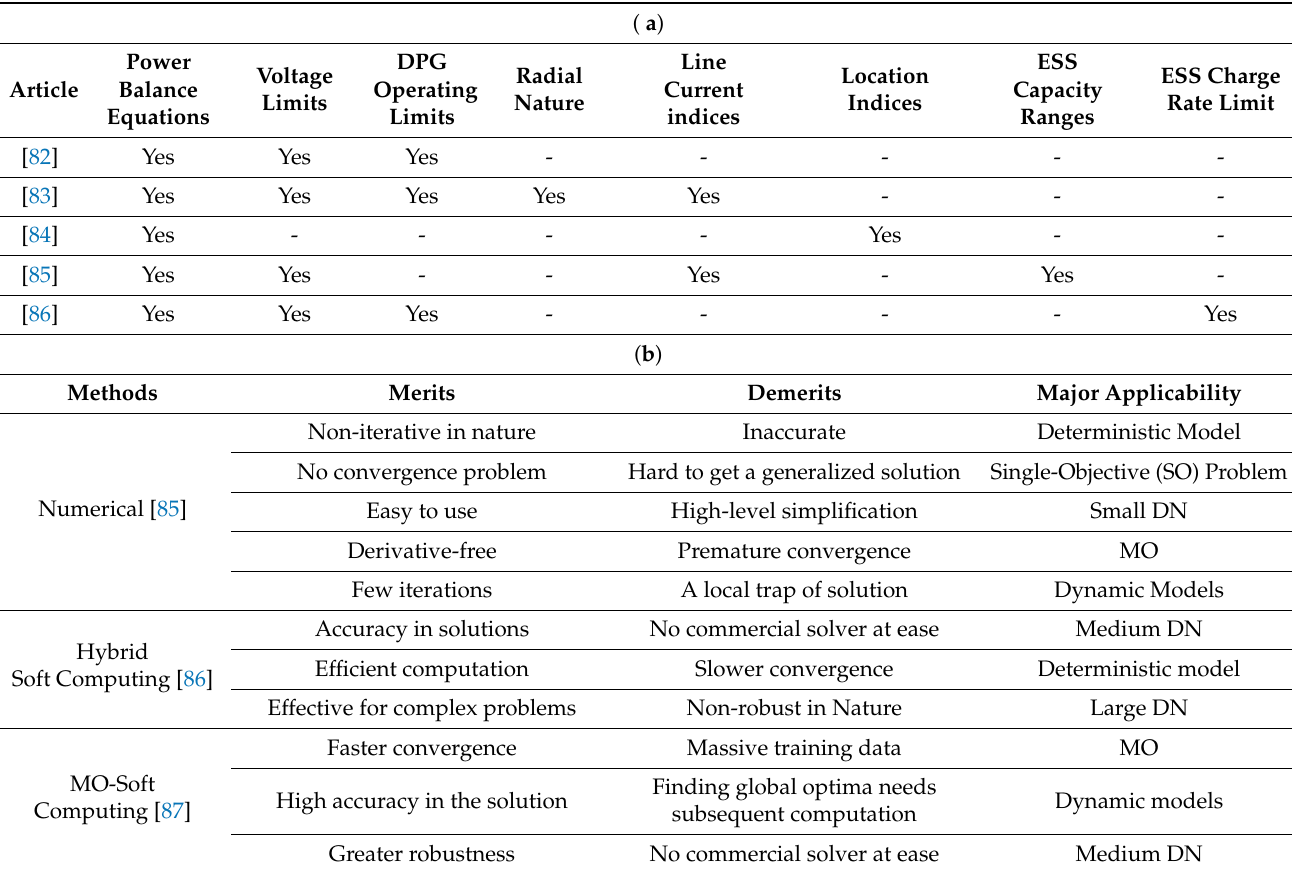
Table 4. ( a ) Considerations of constraints for optimization modeling. ( b ) Comparative analysis for DN